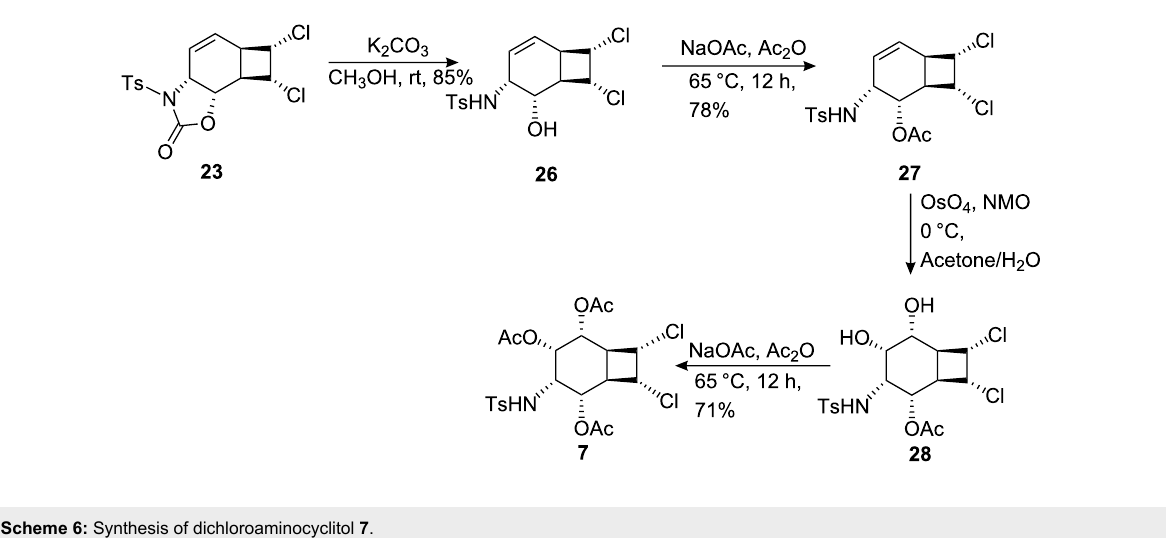
(Figure 2). Irradiation of H 3 (H 3 –CNHTs) at δ 3.85 caused signal enhancements of H 1 , H 2 , and H 4 at δ = 5.45, 5.28 and 5.15, respectively. This result is consistent with a cis -relation- ship between H 1 , H 2 , H 3 and H 4